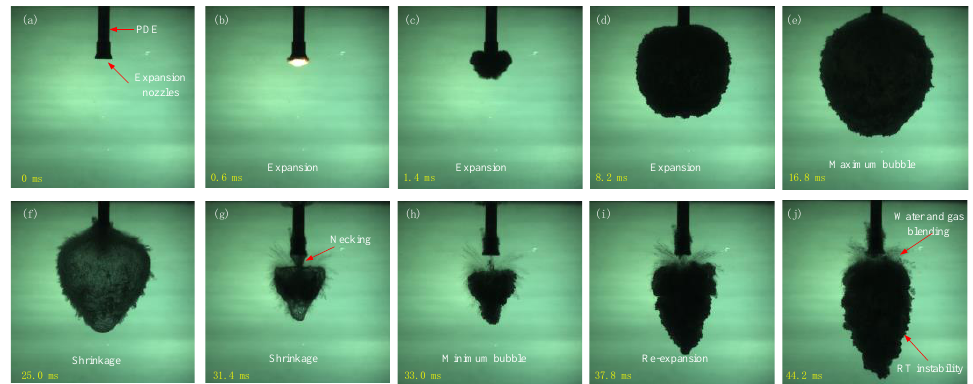
Figure 6. Bubble evolution when the expanding nozzle was installed: ( a ) t = 0 ms, ( b ) t = 0.6 ms, ( c ) t = 1.4 ms, ( d ) t = 8.2 ms, ( e ) t = 16.8 ms, ( f ) t = 25.0 ms, ( g ) t = 31.4 ms, ( h ) t = 33.0 ms, ( i ) t = 37.8 ms, ( j ) t = 44.2 ms.